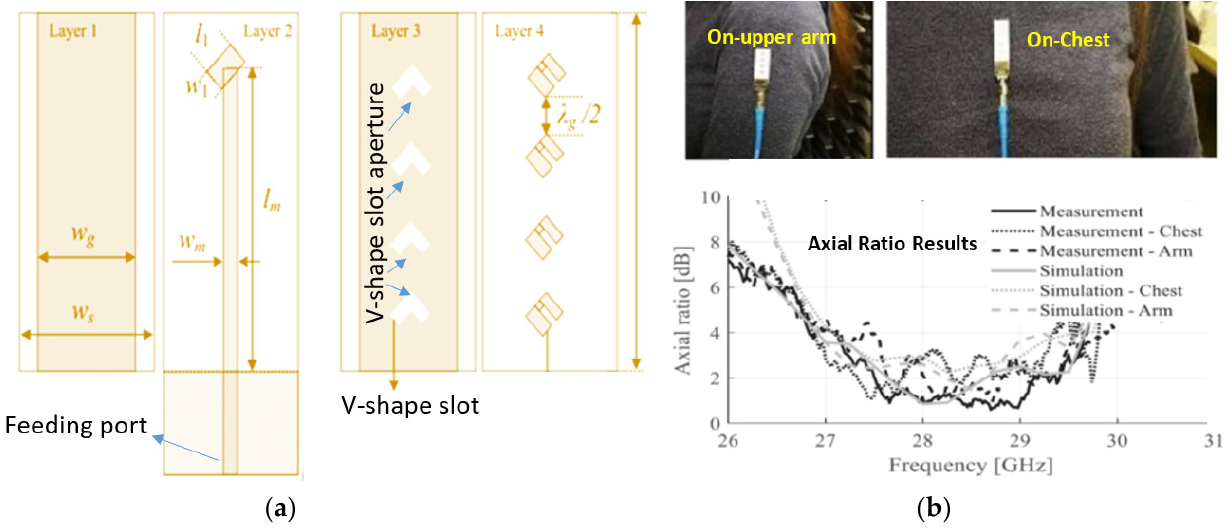
Figure 25. ( a ) Geometry and fabricated photo of the antenna, and ( b ) axial ratio results of the introduced circularly polarized mm-wave wearable antenna for 5G wearable application [146].